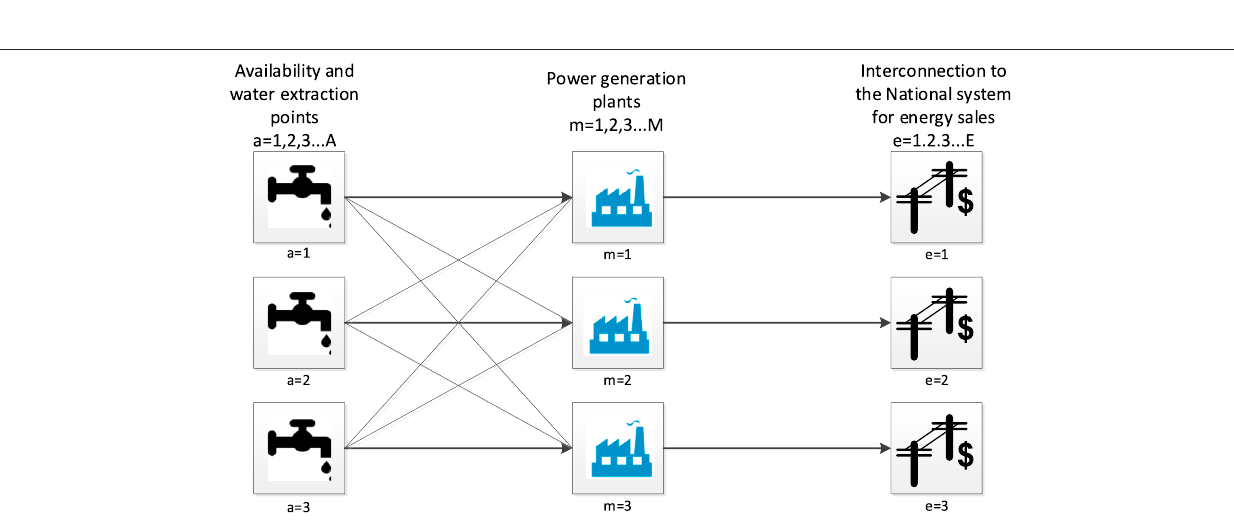
Frontiers in Energy Research |